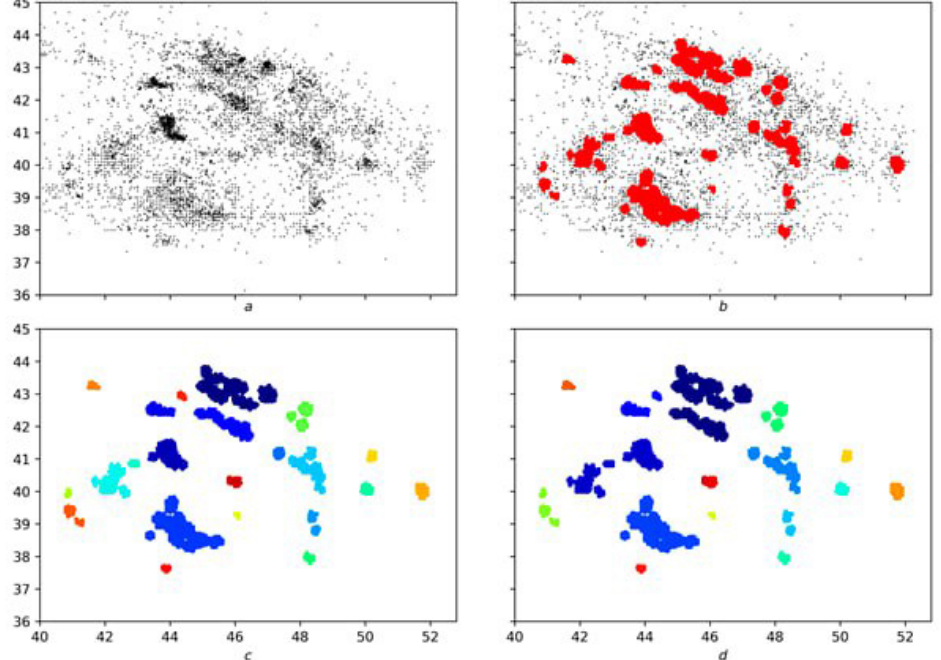
Figure 6. ( a ) Initial array X . ( b ) Result of the first stage of the SDPS algorithm. ( c ) Result of the second stage of the SDPS algorithm with r connectivity components (uniform in color sets). ( d ) Result of the third stage of the SDPS algorithm with edges and quasi-edges (uniform in color